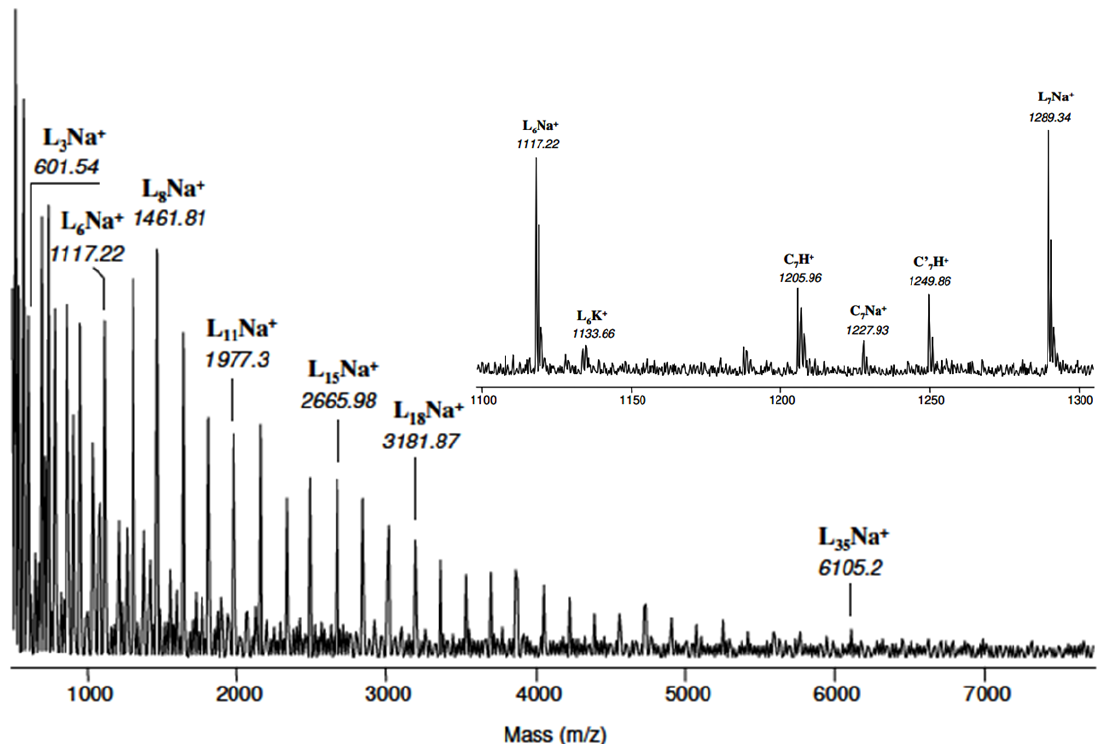
Figure 3. MALDI-TOF chromatogram of PEA-2 sample.